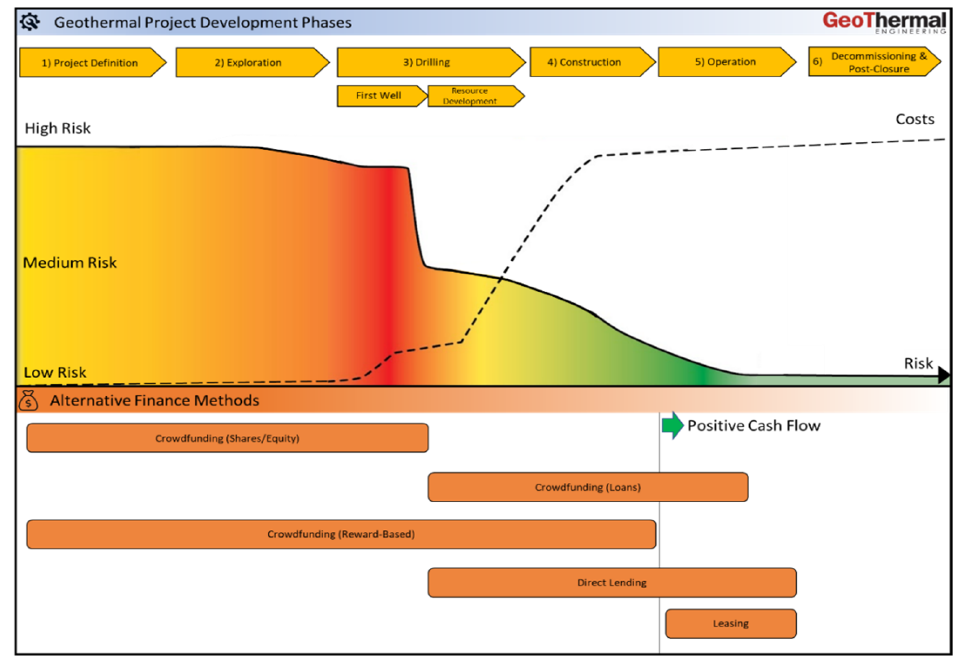
Figure 8. Technical geothermal project development phases, associated resource risks, costs, and most appropriate alternative finance methods. Source: [44], modified after [46,47].